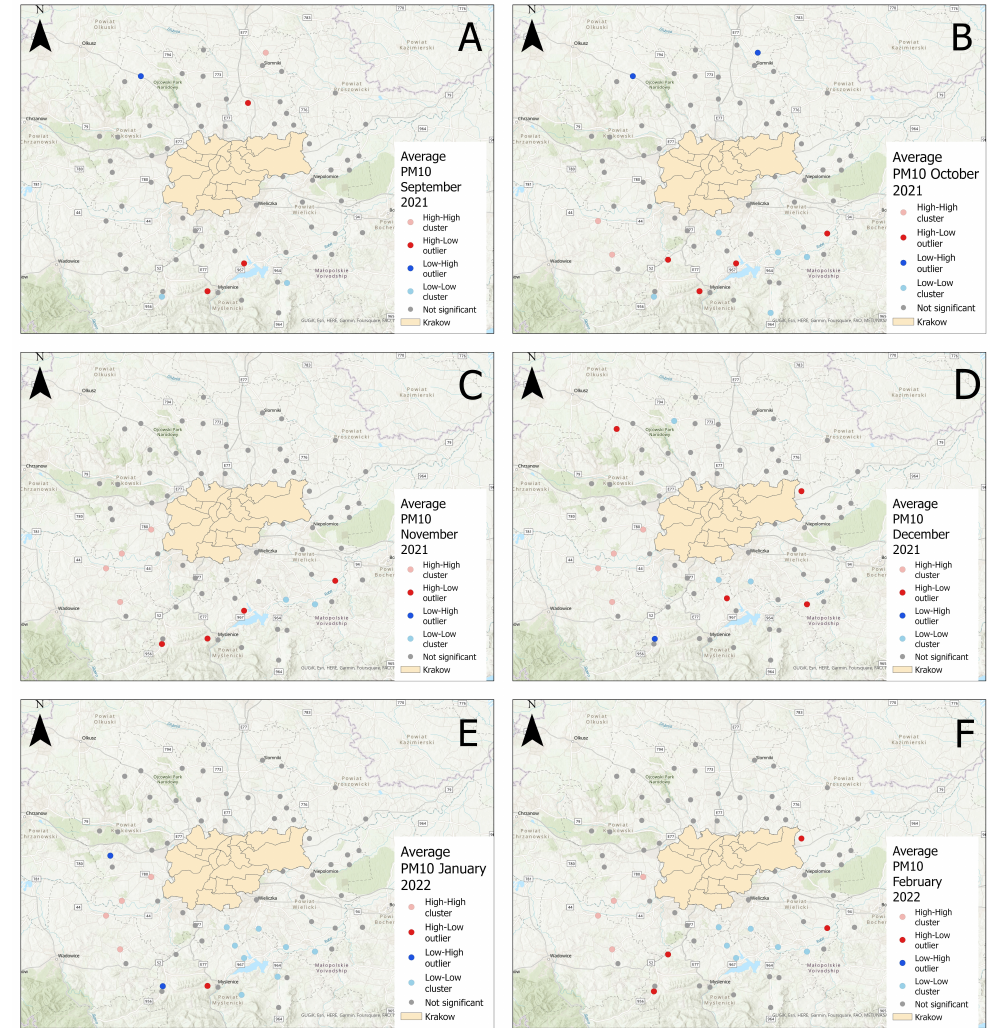
Figure 10. The spatial associations for monthly average PM10 concentrations for high-high and low- low clusters and high-low and low-high outliers using Local Moran’s I. The maps illustrate clustering in September ( A ), October ( B ), November ( C ), December 2021 ( D ), January ( E ), and February 2022 ( F ). Figures 11 and 12 show local Moran’s I cluster maps for maximum PM10 concentration on each month from March 2021 to February 2022. The analysis of maximum values of PM10 enables the detection of places where the highest pollution occurred. By analyzing the maximum concentrations of PM10 for each month, it can be observed that both the anomalies of high values and the clusters of high values are mainly located outside the Krakow area. Throughout the observation period, only clusters of low values were observed within the city of